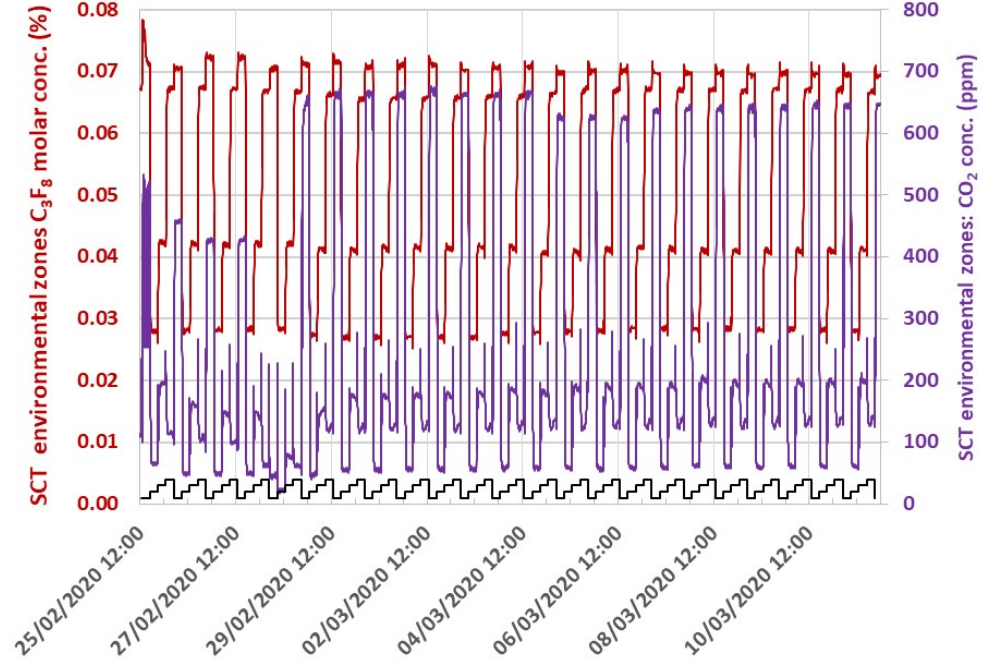
Figure 12. Variations of % molar C 3 F 8 (red) and ppmCO 2 concentrations (violet) seen in four sequentially-monitored N 2 - purged zones surrounding the ATLAS SCT silicon tracker (partitions indicated by repeating ‘valve state’ staircase (black): 1—“Barrel bottom” ➔ 2—“Side C” ➔ 3—“Side A” ➔ 4—“Barrel top” ➔ 1…).